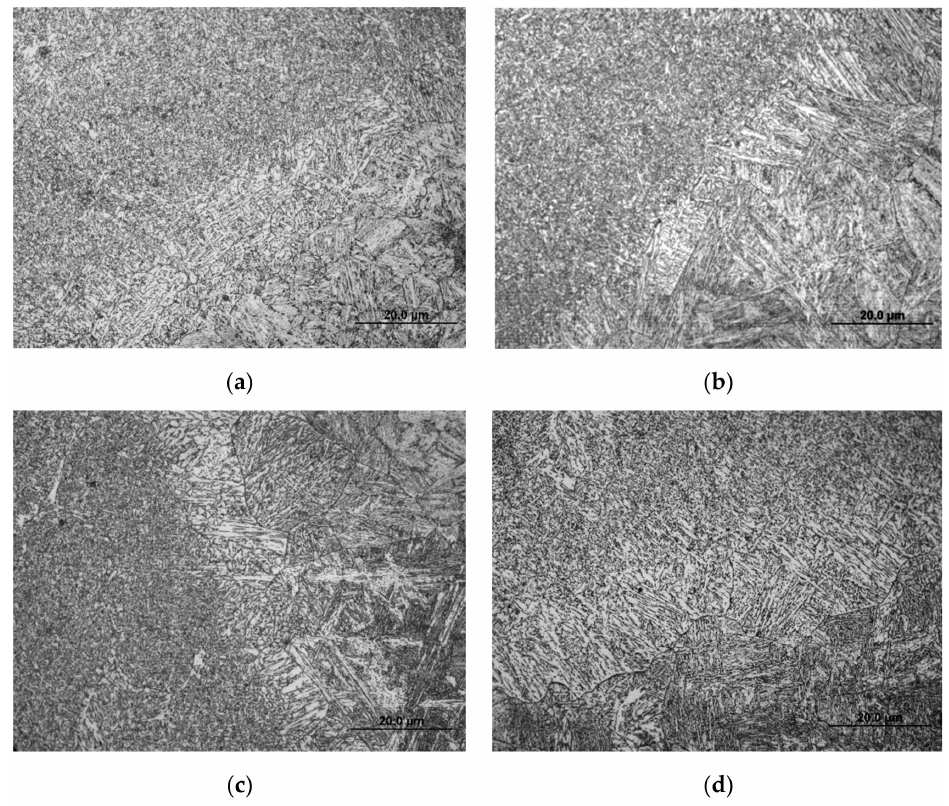
Figure 13. HAZ microstructures under different heat input values [31]. ( a ) E = 0.99 kJ/mm ( b ) E = 1.26 kJ/mm, ( c ) E = 1.56 kJ/mm ( d ) E = 1.89